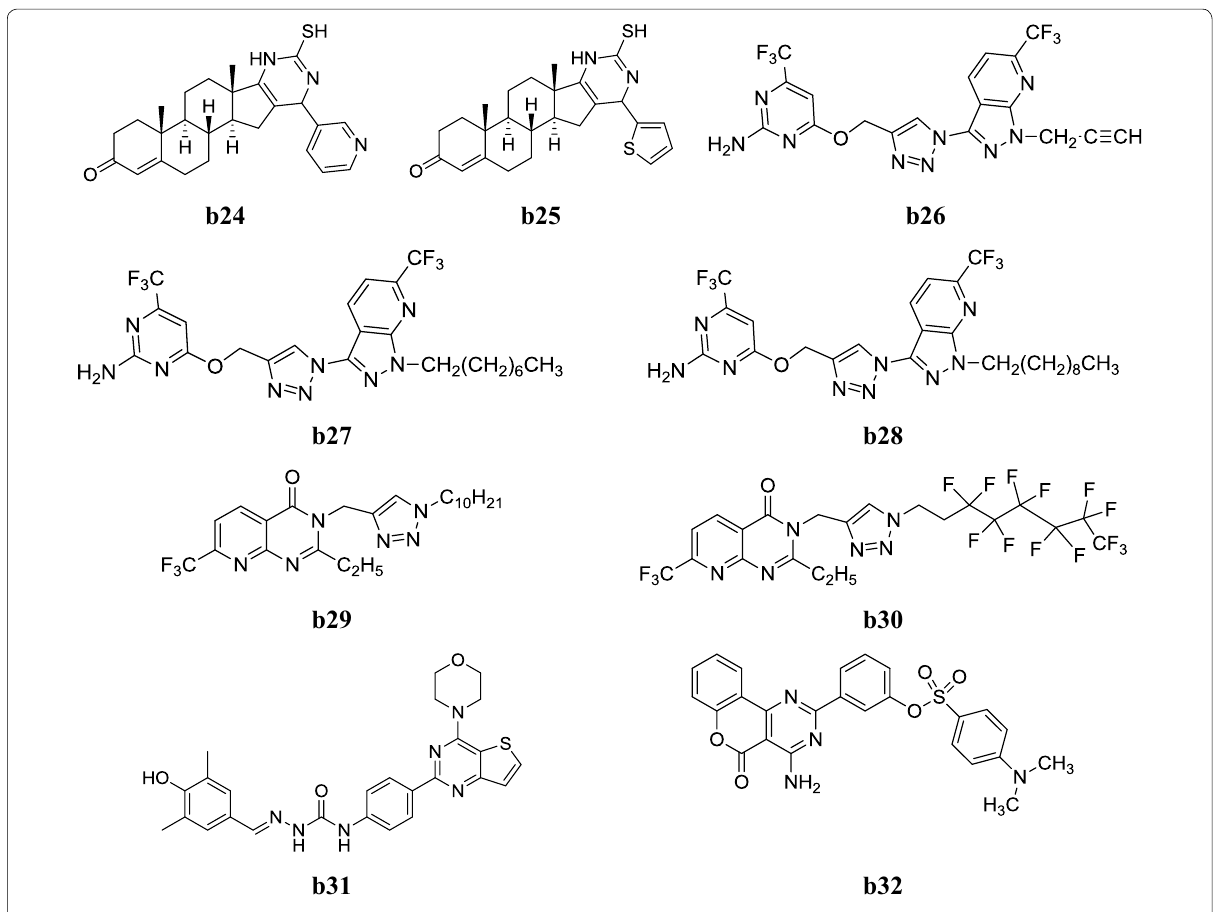
Fig. 7 Chemical structures of the most active anticancer pyrimidine derivatives ( b24 – b32 )